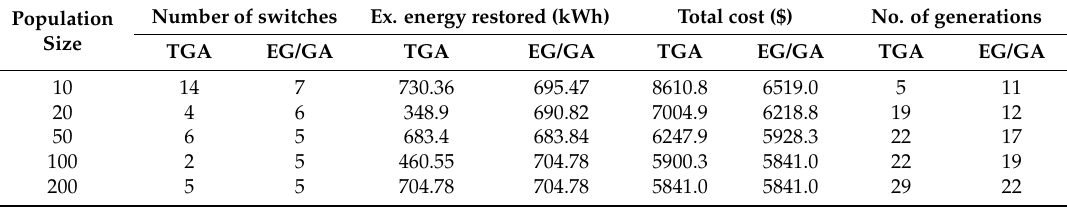
Table 3. Comparison of traditional genetic algorithm (TGA) and EG for Feeder 1.